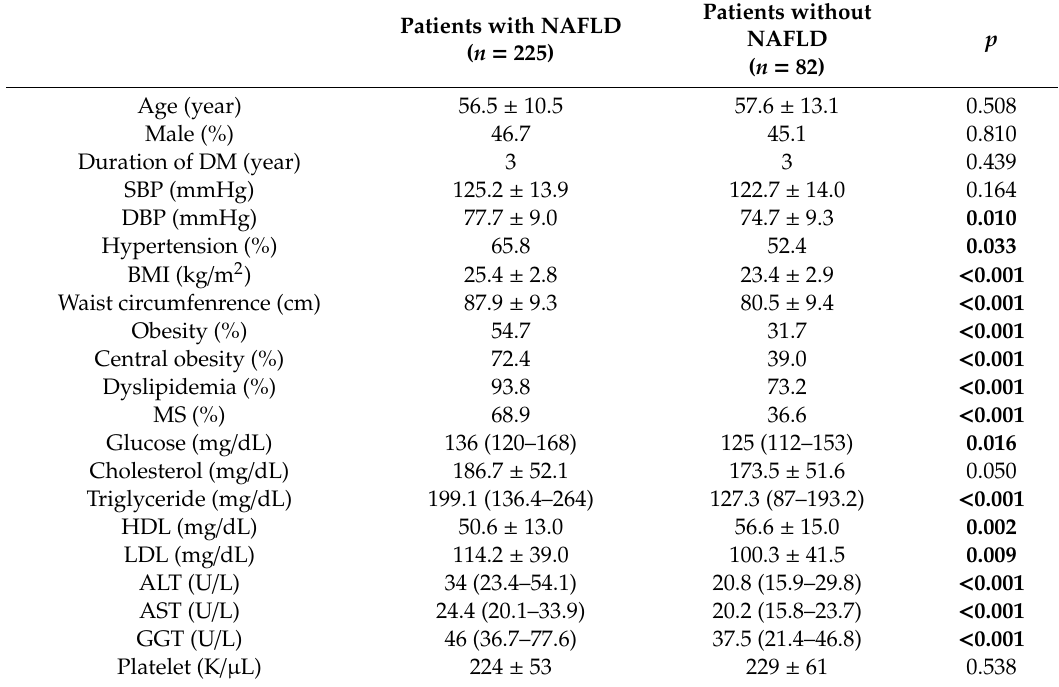
Table 1. Features of patients with and without non-alcoholic fatty liver disease (NAFLD) based on transient